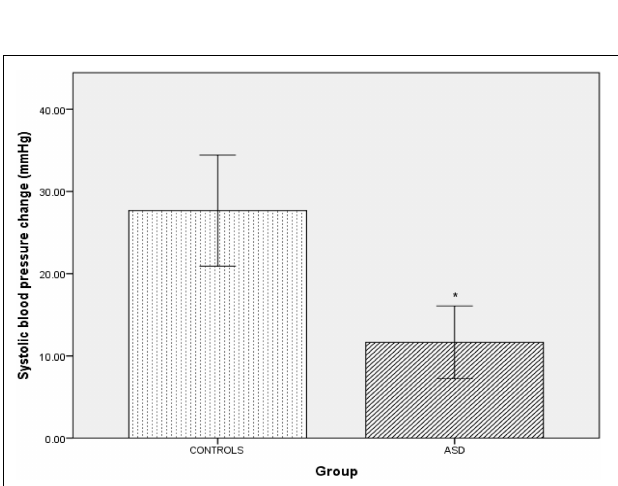
FIGURE 1 | | Baseline supine heart rate in controls and ASD. BPM, beats per minute. *Refer to a statistically significant finding.